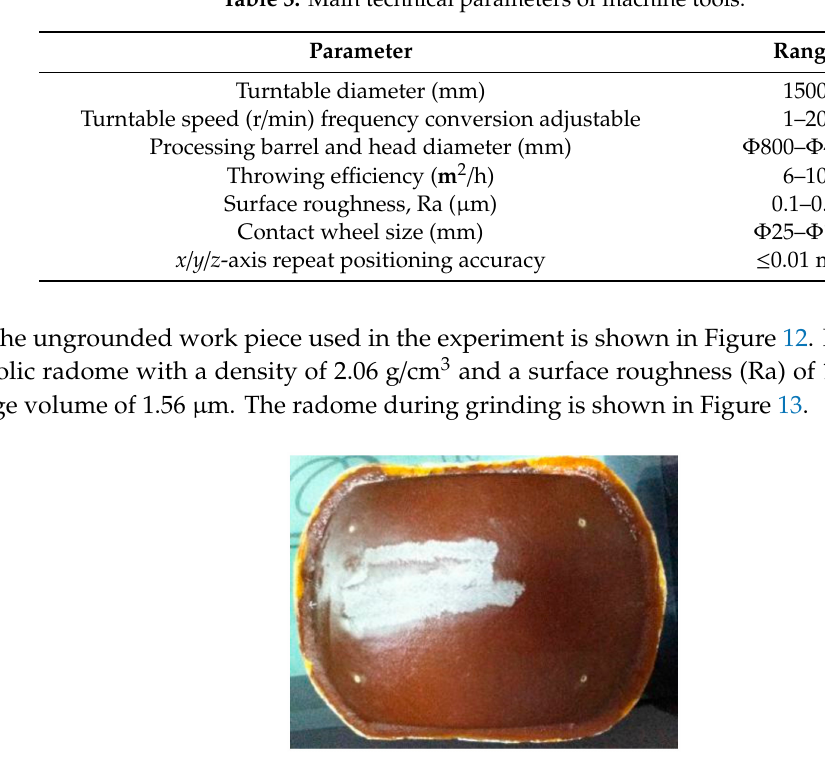
Figure 12. Unground radome diagram.